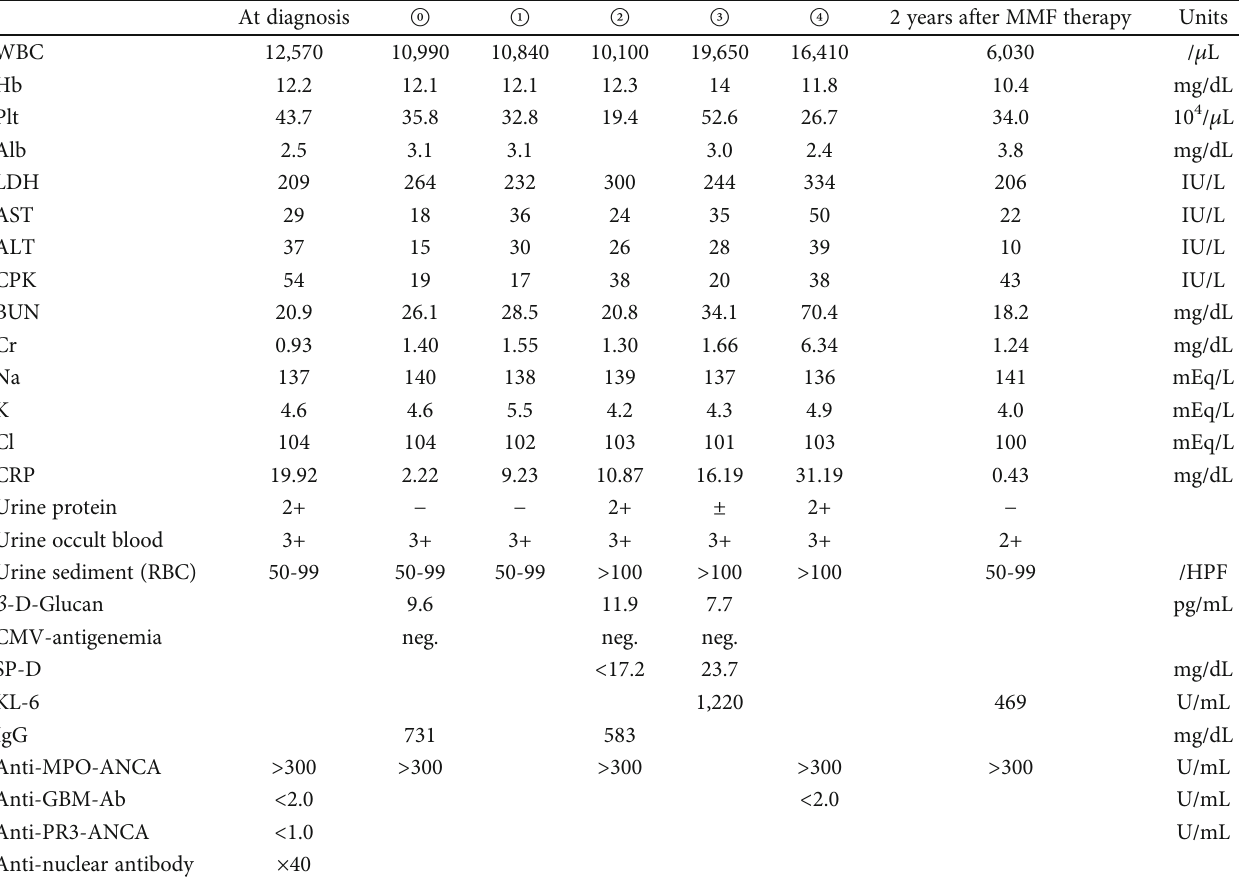
Table 1: Laboratory fi ndings during the course of the